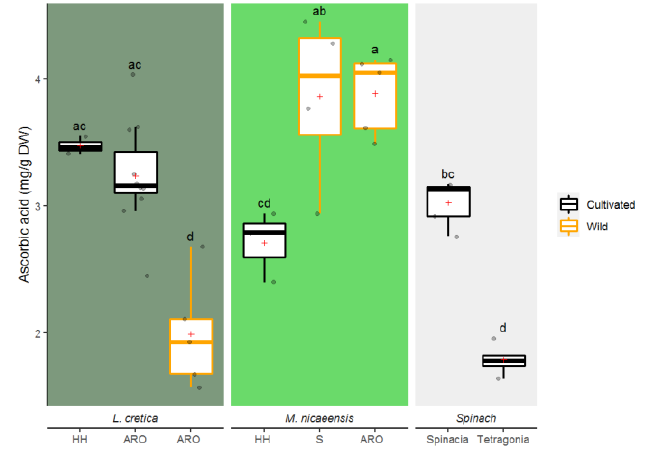
Figure 5. Ascorbic acid in leaves of two Malvaceae species and two spinach species. Different lowercase letters indicate significant differences between populations of green leaves ( p < 0.05). Species names and abbreviations of locations are given in the lower line. HH = Havat Hanoi, ARO = research site at the Agricultural Research Organization; S = agricultural area near Sandala village, North Israel. Box plot color indicates “Cultivated” in an agricultural field, or “Wild”, grown wildly at field margins or feral fields. Median and average are indicated as a horizontal line within the box plot and red cross respectively, and gray dots denote results of single analyses.